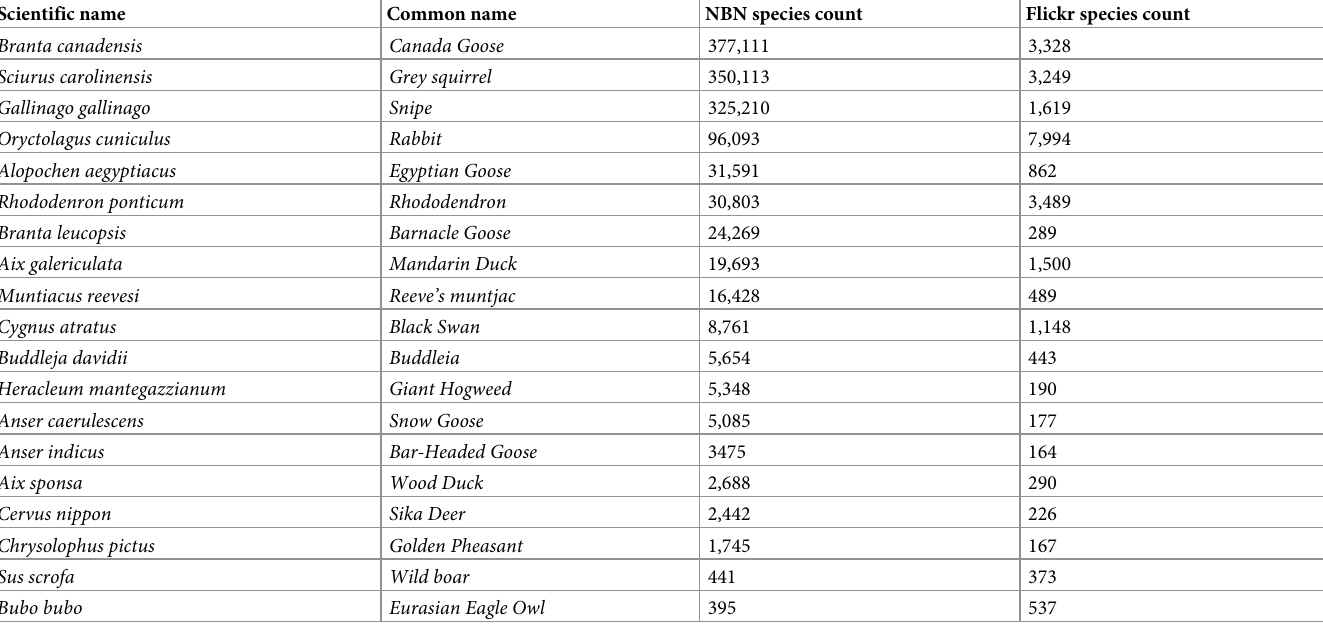
Table 4. Species occurrences for NBN and Flickr for invasive species with number of occurrences above